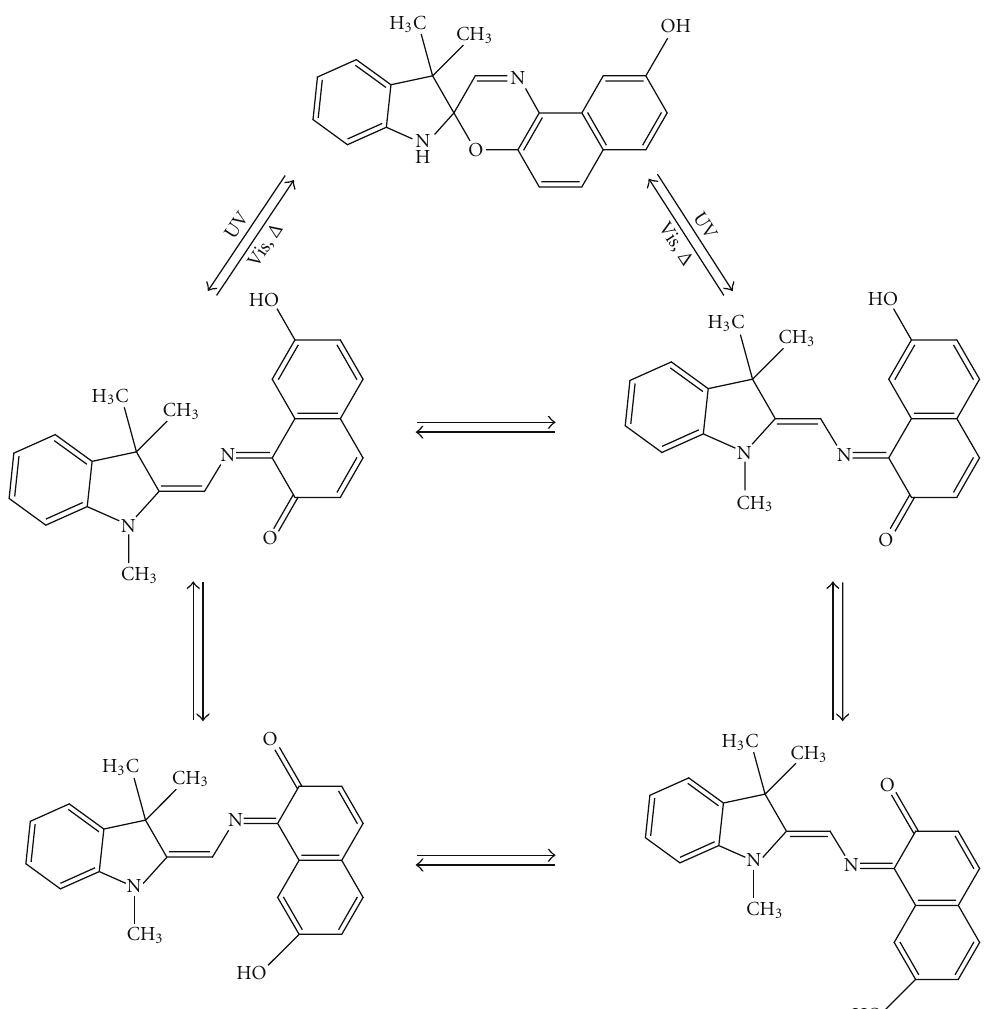
Figure 1: Mechanism of photochromic transformations of